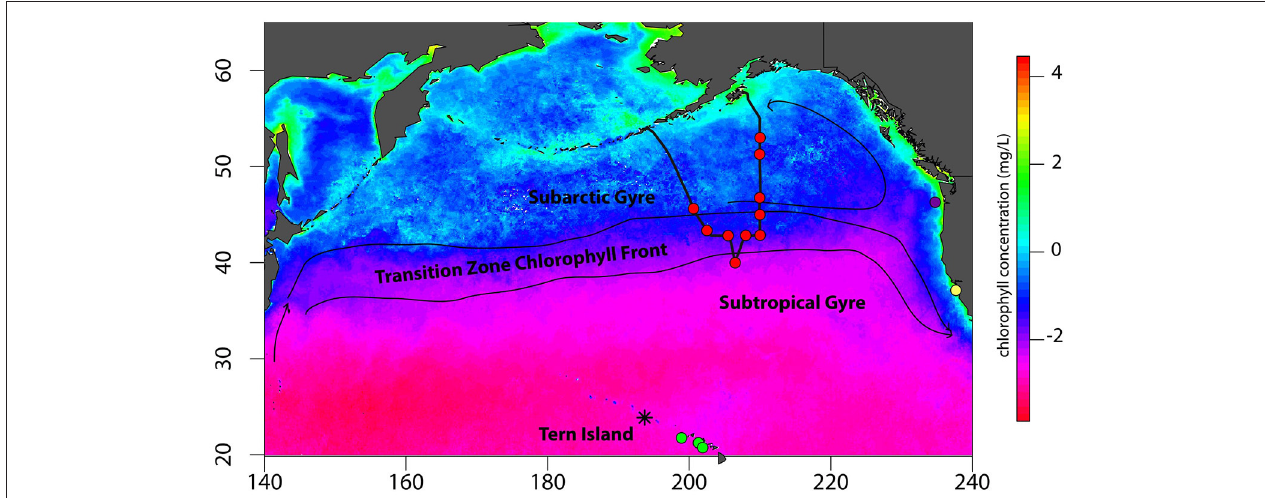
FIGURE 1 | Collection sites across the North Pacific ocean basin for albatross prey specimens. The track of the T/S Oshoromaru is represented by the thick black track-line. Prey collection sites are denoted with colored circles: Red circles represent the locations of midwater trawls and squid jigging in the North Pacific Transition Zone, Subtropical Gyre, and Subarctic Gyre. Green circles identify locations where prey samples were collected in subtropical waters near Tern Island with a cobb trawl. The purple circle identifies the midwater trawl location in the California Current. Lastly, the yellow circle identifies the Año Nuevo breeding colony of northern elephant seals from which blubber samples were collected in a concurrent study (Goetcsh et al. unpublished data). Black lines and arrows are a generalized representation of basin-scale currents that influence frontal zones and foraging habitats of North Pacific albatross. Chlorophyll-a concentrations are the 8 year average (2004:2011) from the month of August. Rasters were downloaded from http://coastwatch.pfeg.noaa.gov/coastwatch/CWBrowserWW360.jsp.